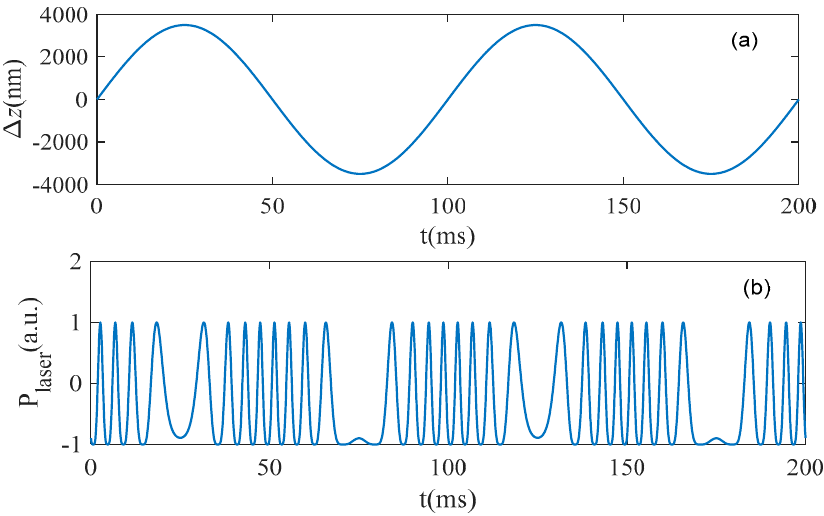
Figure 3. Simulation results of the LFI signal corresponding to out-of-plane displacement ∆ z (7000 nm p–p). ( a ) The simulated displacement of ∆ z . ( b ) The simulated LFI signal.